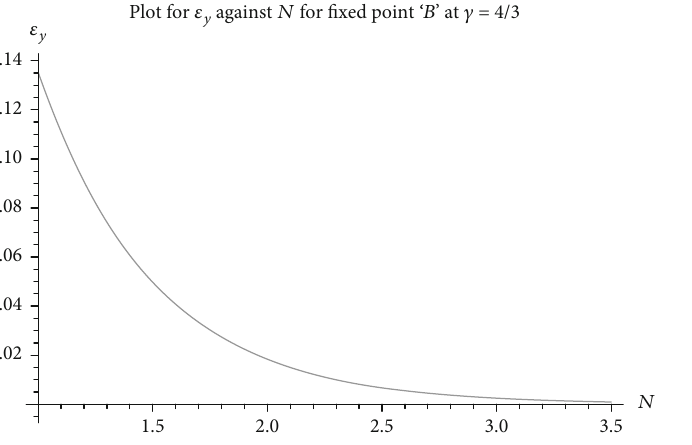
Figure 14: Shows the variation of perturbations along the y -axis ( ϵ